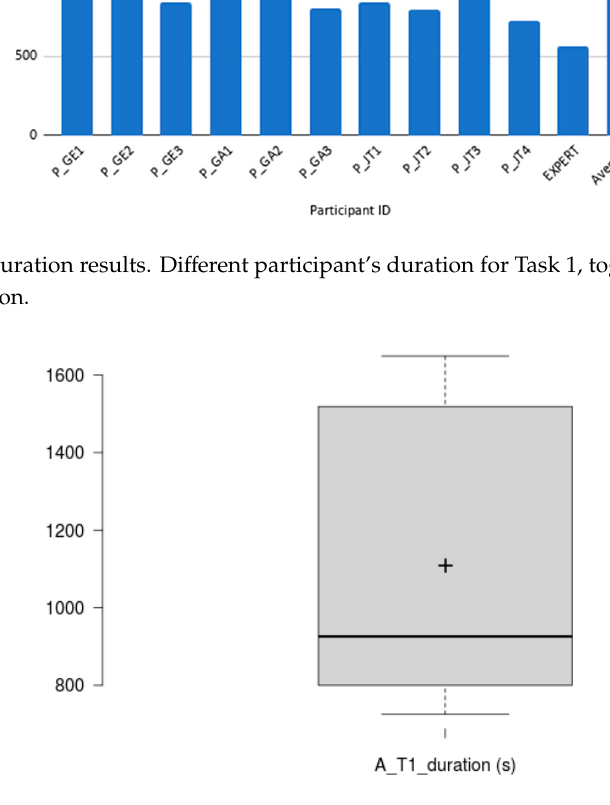
Figure 13. Task 1 duration variability. Box plot showing overall duration scores for Task 1. This does not, however, include expert user’s duration. The plus sign denotes the average value.